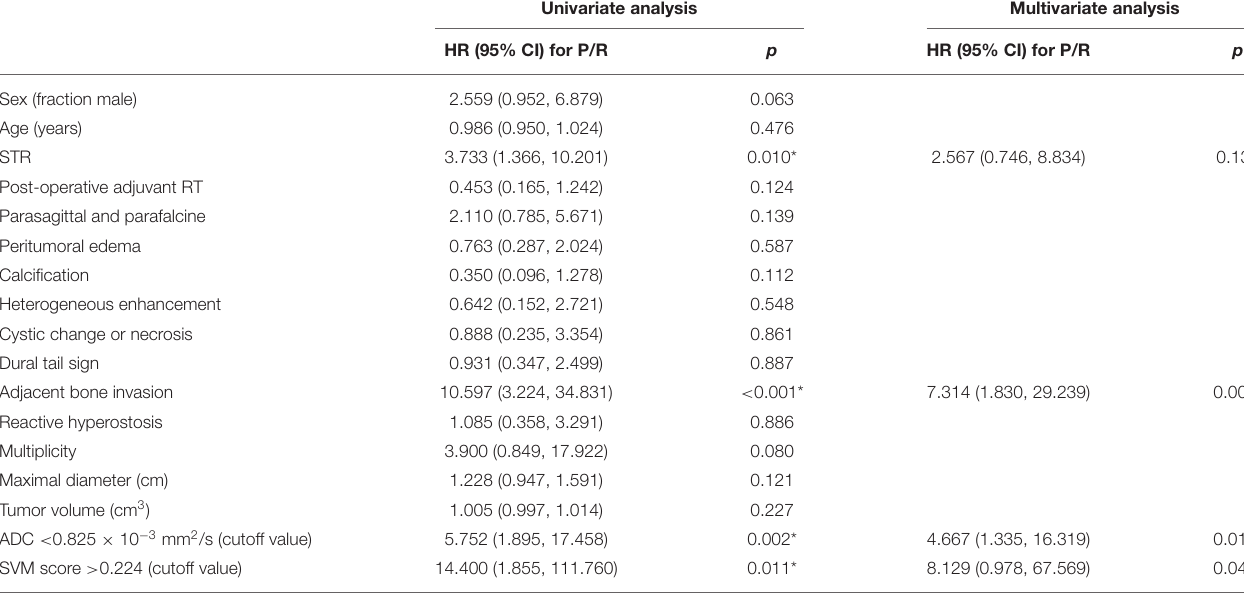
TABLE 2 | Cox proportional hazards analysis for